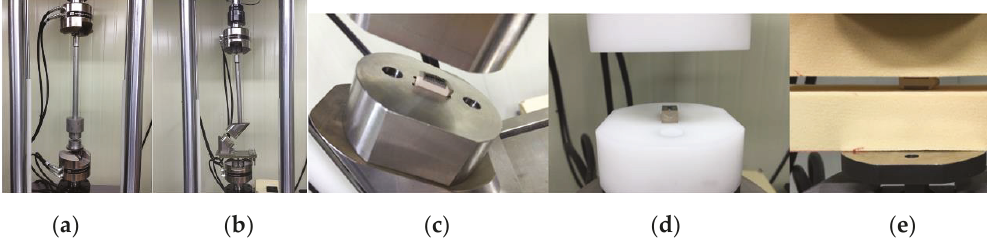
Figure 5. Test jig and test block: ( a ) test jig for compression, torsion and subsidence, ( b ) test jig for compression shear, ( c ) test block for static compression and compression shear, torsion, ( d ) test block dynamic compression, ( e ) test block for subsidence.